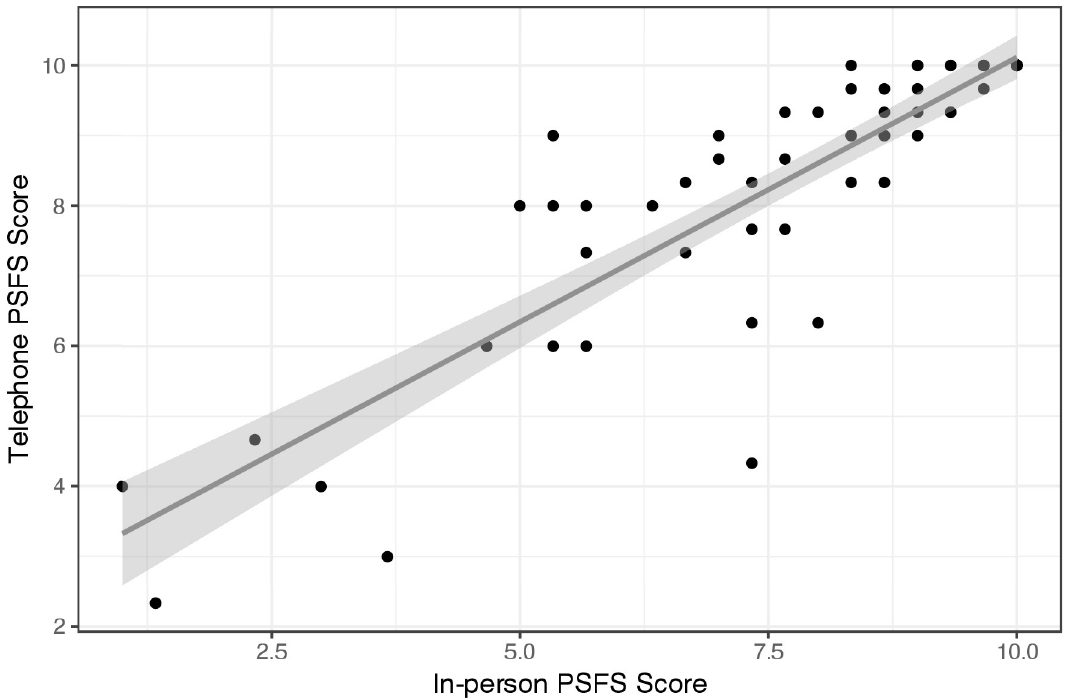
Fig 2. Spearman correlation coefficient demonstrating strong linear correlation between telephone and in-person administrations of the patient-specific functional scale.